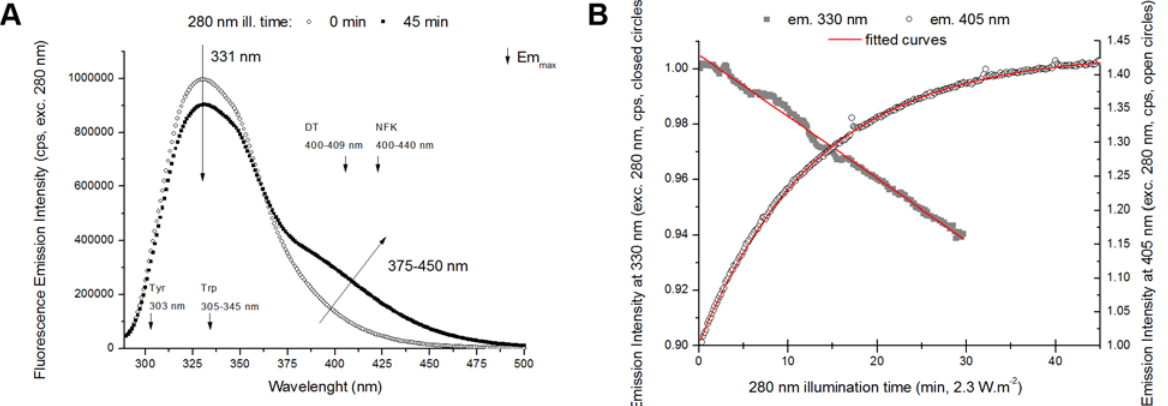
Fig 6. Fluorescence emission of human plasminogen (280 nm excitation). A - Fluorescence emission spectra (280 nm exc.) obtained before and after 280 nm light continuous illumination (45 min) of human plasminogen in solution. 280 nm illumination leads both to a decrease in emission intensity at 330 nm and to an increase in emission intensity between 375 nm and 450 nm. Small decreasing arrows indicate the wavelengths of maximum emission intensity (Em max ) of Trp, Tyr, DT and NFK in solution. B - Fluorescence emission intensity kinetic traces obtained at 330 nm and 405 nm (exc. 280 nm) upon continuous illumination of human plasminogen with 280 nm light. Fitting of the experimental trace obtained with emission fixed at 330 nm and 405 nm was carried out using an exponential function F(t) = C 1 – C 2.e - kt . The fitted parameter values and corresponding errors, and root mean square error values were obtained after fitting the kinetic trace (Table 5 and Materials and Methods).